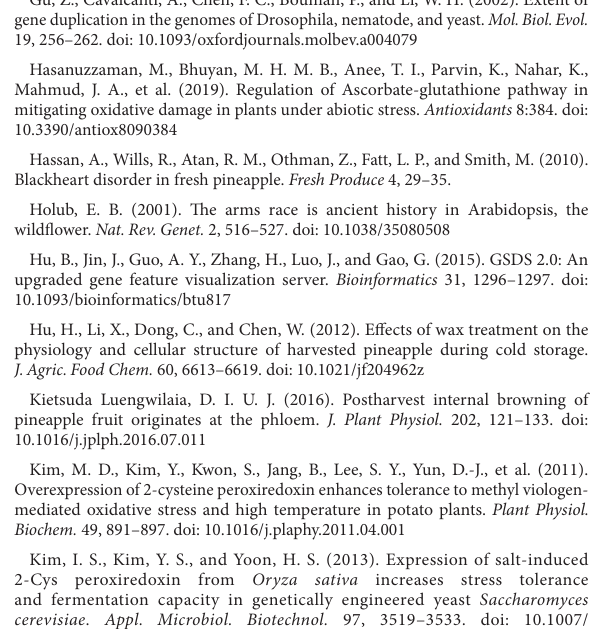
SUPPLEMENTARY TABLE 1 Duplication events and divergence time analysis results. SUPPLEMENTARY TABLE 2 FPKM values of different tissue and development of AcPRXs . SUPPLEMENTARY TABLE 3 FPKM values of different storage timepoint in AsA treatment and control group of AcPRXs . SUPPLEMENTARY TABLE 4 Primers used in this